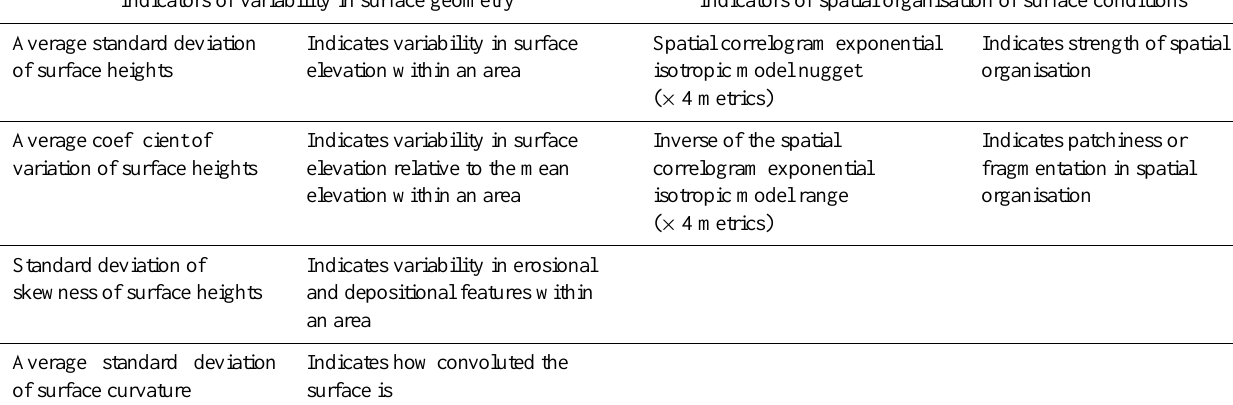
Table 2. Summary of the indicators used to calculate the index of floodplain surface complexity (FSC). Averages and standard deviations of the surface metrics (left columns) are calculated from 50 random sample locations throughout each floodplain. The nugget and range from Moran’s I spatial correlograms (right columns) are extracted from the exponential isotropic models fit to these. See Scown et al. (2015a) for detailed calculation